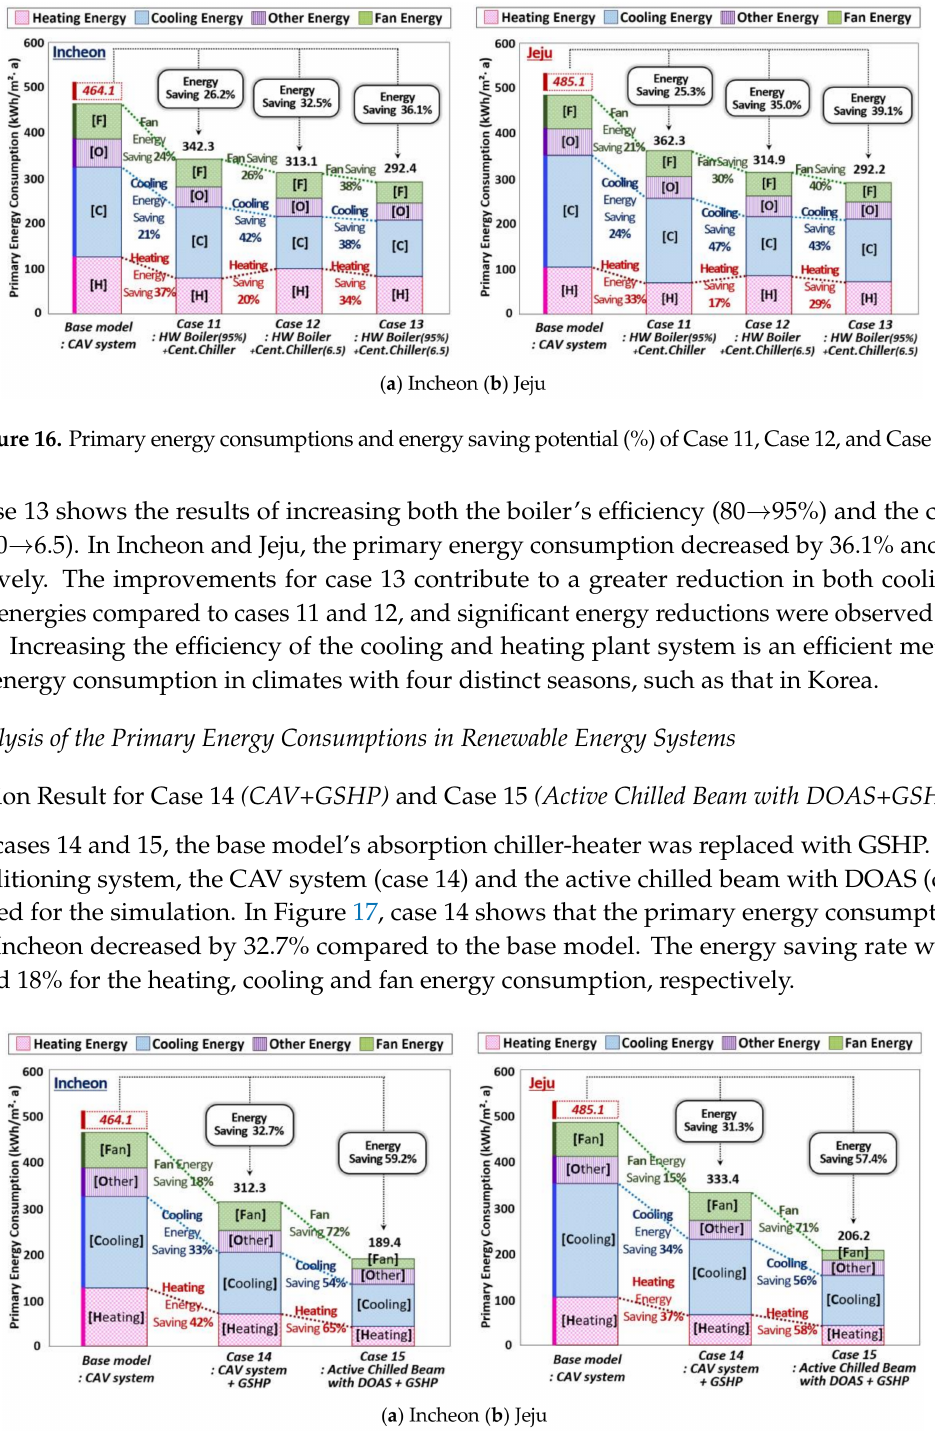
Figure 17. Primary energy consumptions and energy saving potential (%) of Case 14 and Case